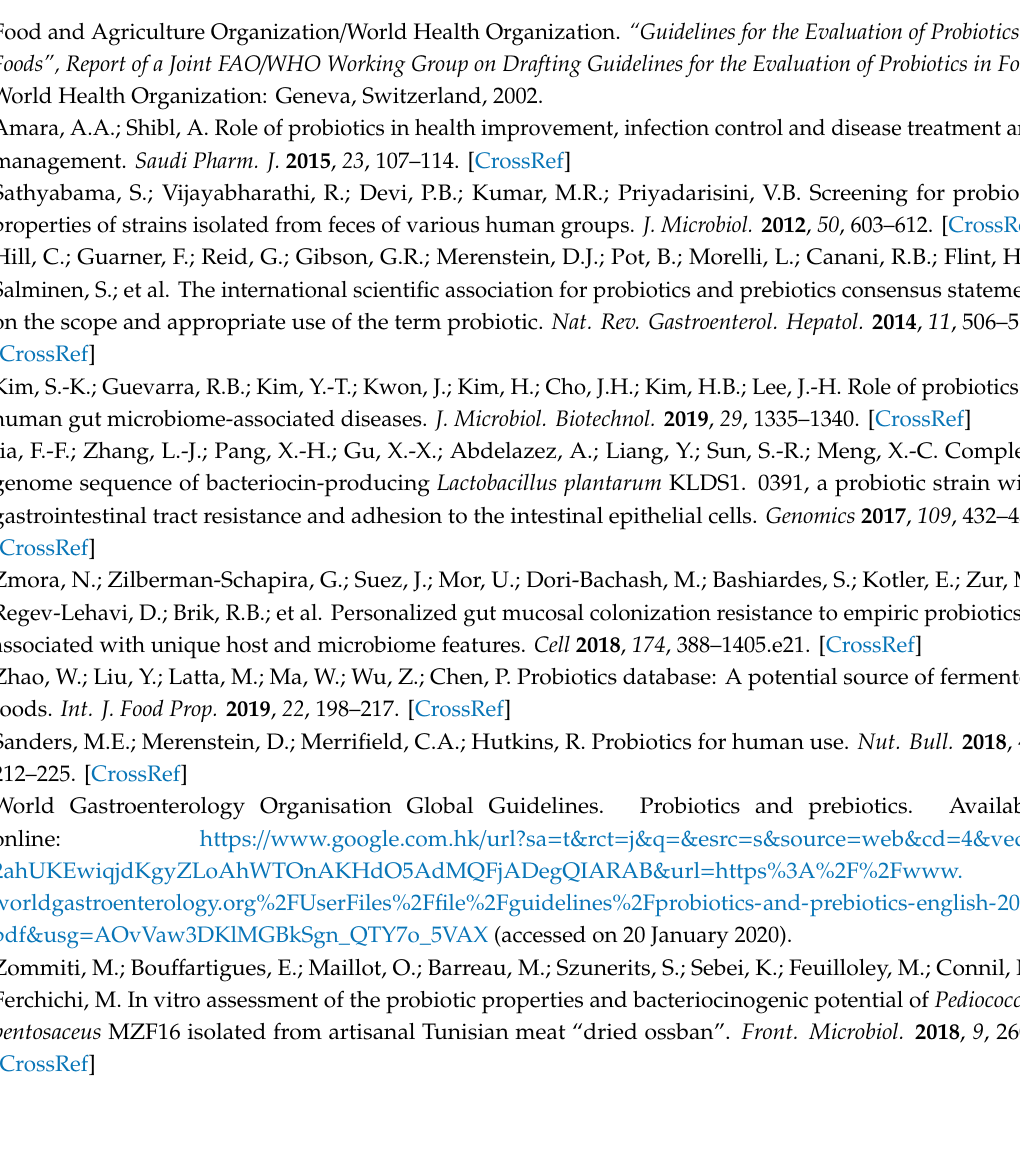
Figure S1: Phylogenetic relationship of the partial 16S rRNA gene sequences representing the isolates used in this study and of sequences obtained from the Genbank database. The 16S rRNA gene sequences from Ferroplasma acidiphilum were used as outgroup. Trees were constructed using the neighbour-joining method, using the MEGA-7 software. The scale bar indicates 0.1 nucleotide substitution per sequence position. Table S1: Origin of LAB isolates used in this